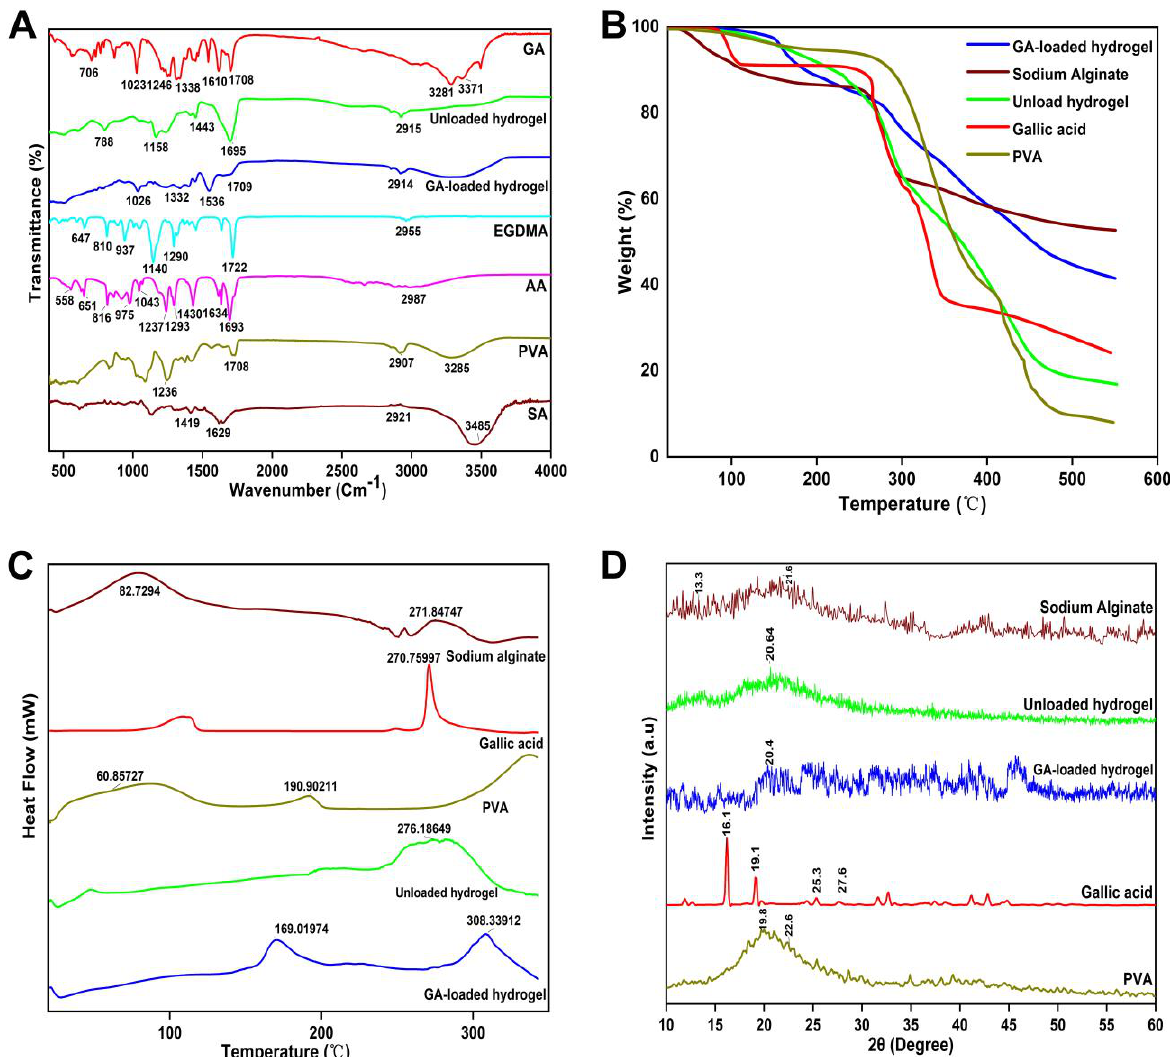
Figure 1. FTIR spectra ( A ), TGA ( B ), DSC ( C ), and XRD ( D ) of prepared hydrogel membranes and their pure components. their pure